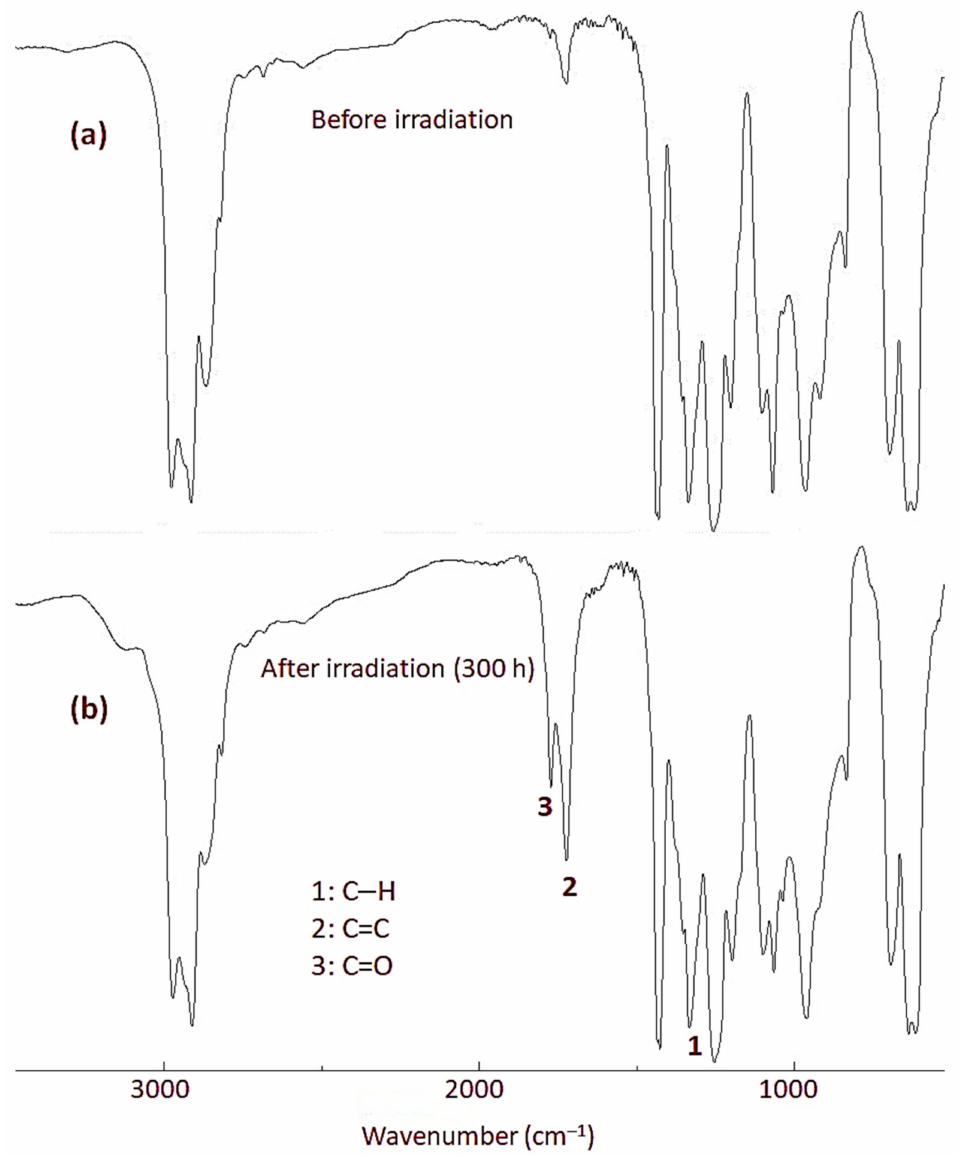
Figure 5. FTIR spectra of blank PVC file ( a ): before irradiation and ( b ): after irradiation. Following irradiation, Equation (3) was used to calculate the values of I C=O and I C=C which were plotted against the duration of irradiation (Figures 6 and 7). The values of I C=O and I C=C increased with irradiation time and the changes were highest for the blank PVC film. The increases in the I C=O and I C=C were lower for the PVC blends with complexes 1 – 5 when compared to the blank film. The lowest I C=O and I C=C were observed for the films with the highly aromatic complexes 1 and 3 . So, the I C=O values after 300 h of irradiation were 0.98, 0.53, 0.66, 0.62, 0.72, and 0.79 for the blank PVC film, and those containing complexes 1 , 2 , 3 , 4 , 5 , respectively. The corresponding I C=C values at the end of irradiation were 0.93, 0.53, 0.66, 0.62, 0.70, and 0.77,